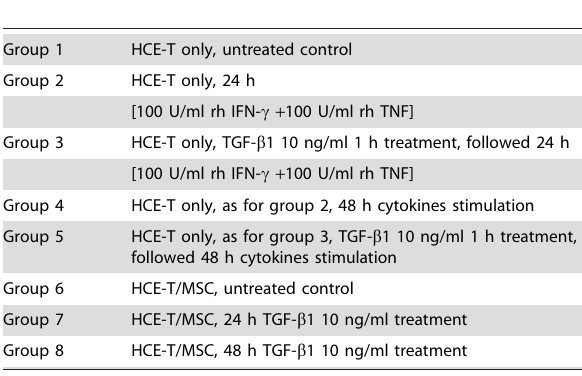
Table 4. Groups for exogenous TGF- b 1